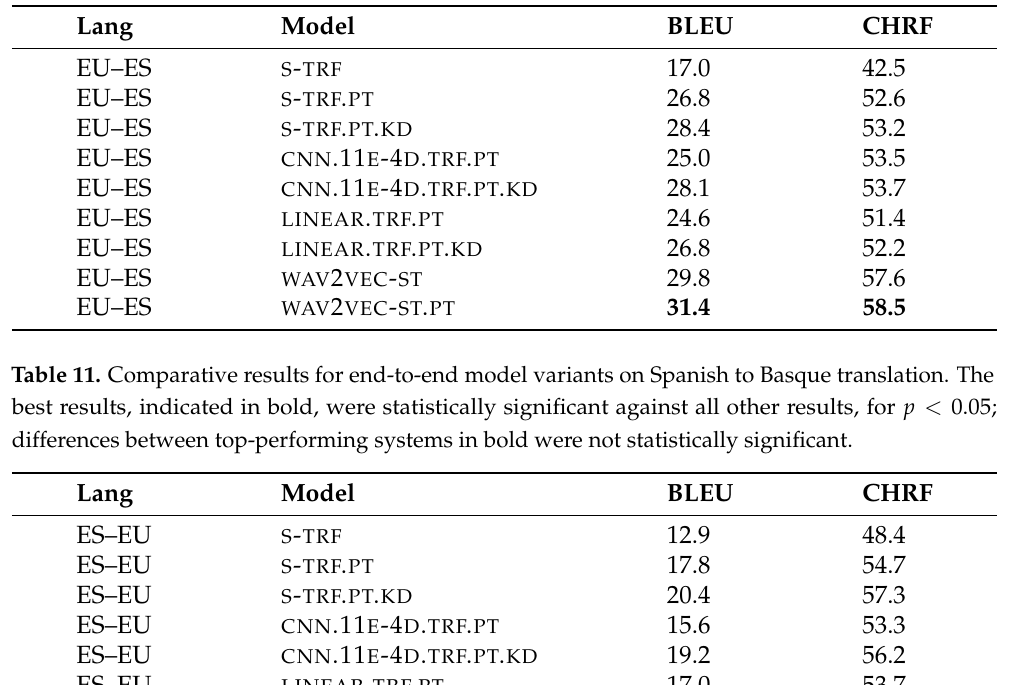
Table 10. Comparative results for end-to-end model variants on Basque to Spanish translation. The best results, indicated in bold, were statistically significant against all other results, for p < 0.05.